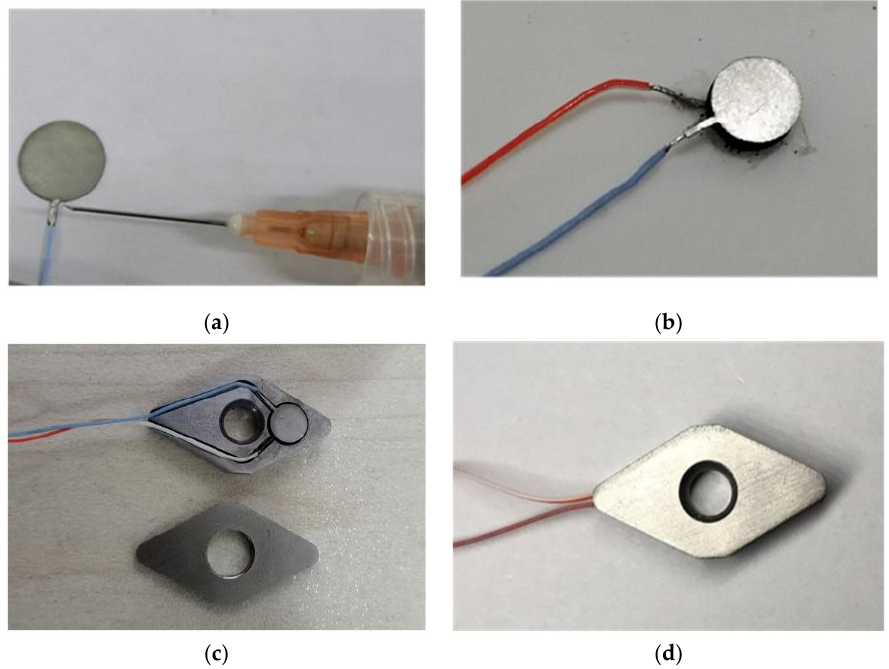
Figure 10. Process of the cutting force sensor packaging: ( a ) connecting the wires and electrodes; ( b ) contacting the electrodes with the SiAlCO ceramic; ( c ) spraying the insulating paint on the surface of the cover plate and the substrate; ( d ) the SiAlCO ceramic with the electrodes are put into the groove of the substrate, and the cover plate is welded to the substrate using laser welding.